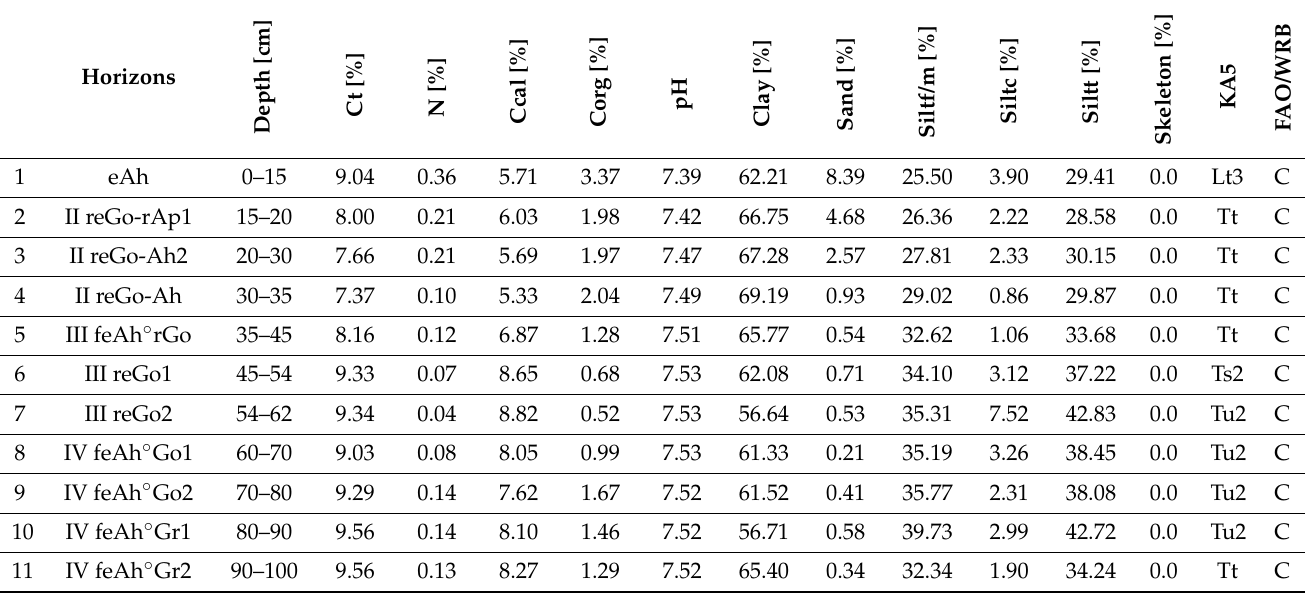
Table 2. Chemical properties and particle size distribution of the soil profile Pulling